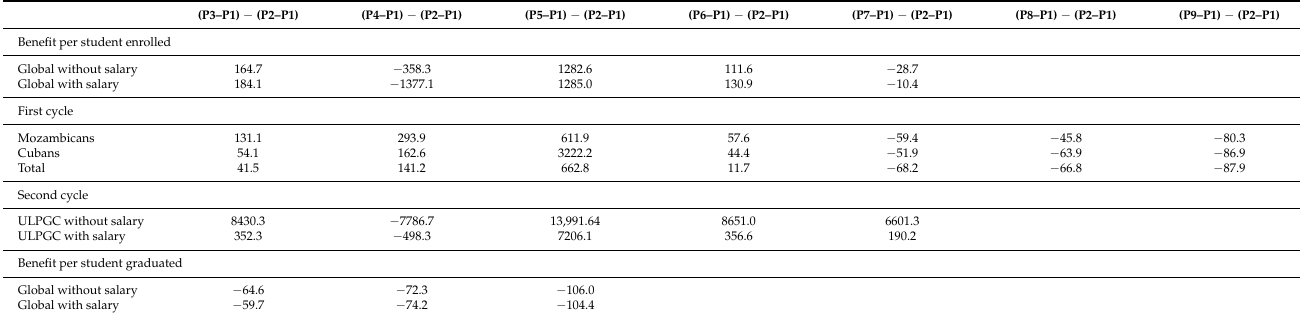
Table 3. Benefit of the efficiency per student enrolled and graduated (difference between promotions Pi and P1 presented as a percentage).